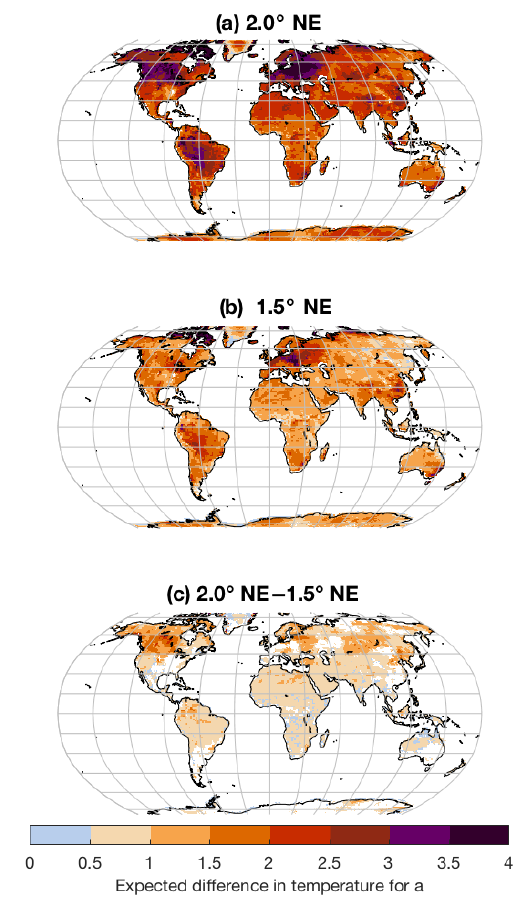
Figure 5. Maps showing the expected difference from 1976 to 2005 in temperature for a 1-in-20-year 3-day warm event for (a) 1.5degNE, (b) 2.0degNE and (c) the difference in temperature be- tween each scenario.